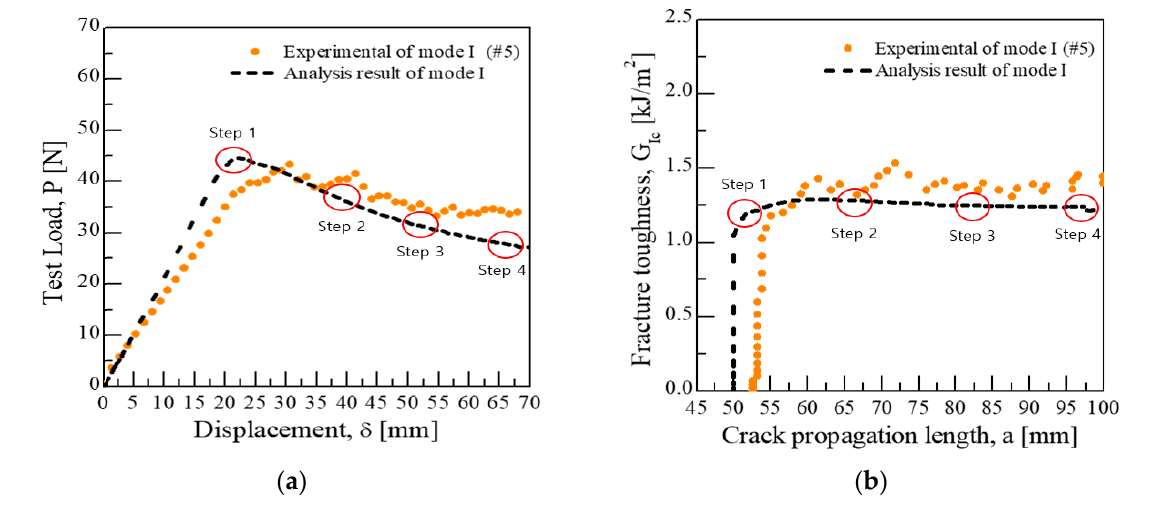
Figure 12. Comparative analysis of specimen-level FE analysis results and Mode I test results: ( a ) P − δ curve and ( b ) G I − a curve.